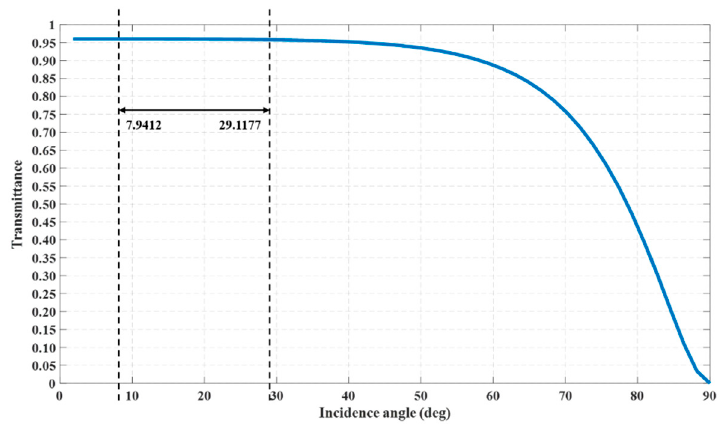
Figure 11. The relationship between transmittance and the incident angle of the down channel.